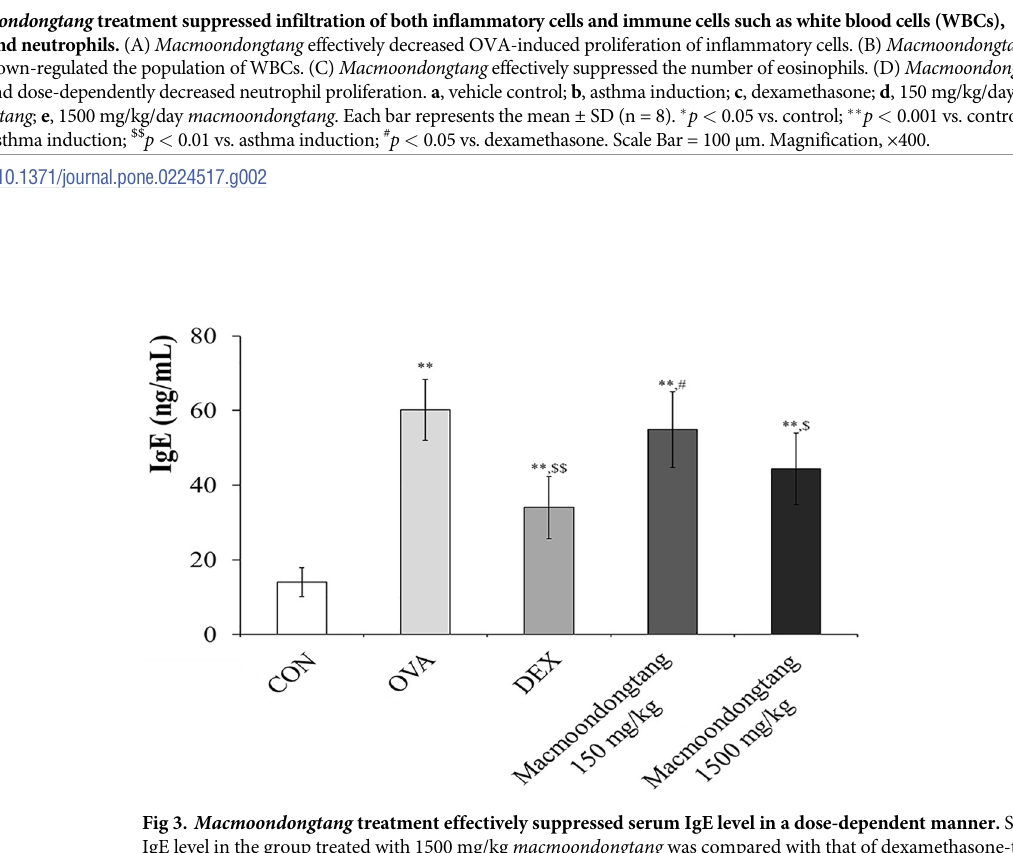
PLOS ONE | https://doi.org/10.1371/journal.pone.0224517 December2,